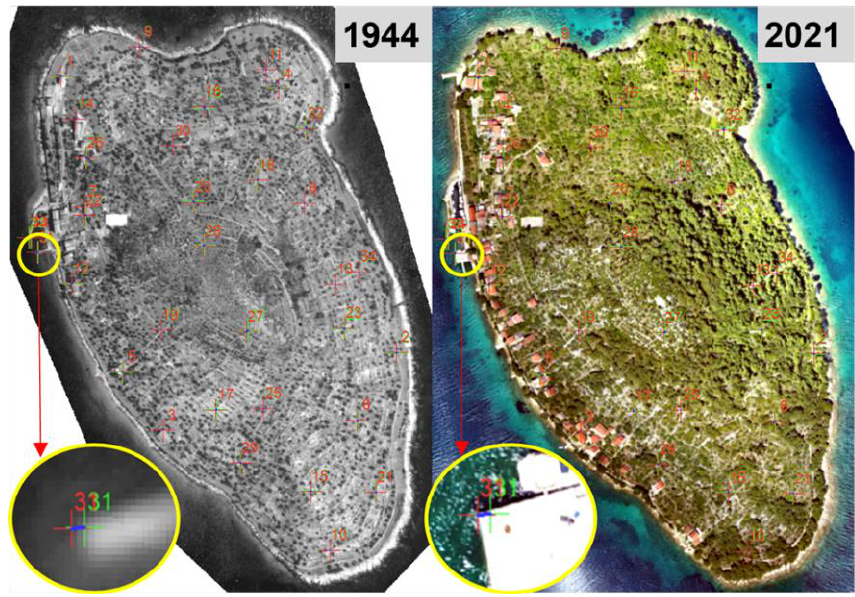
Figure 10. Example of data harmonization between HAP from 1944 and DOP from 2021 .